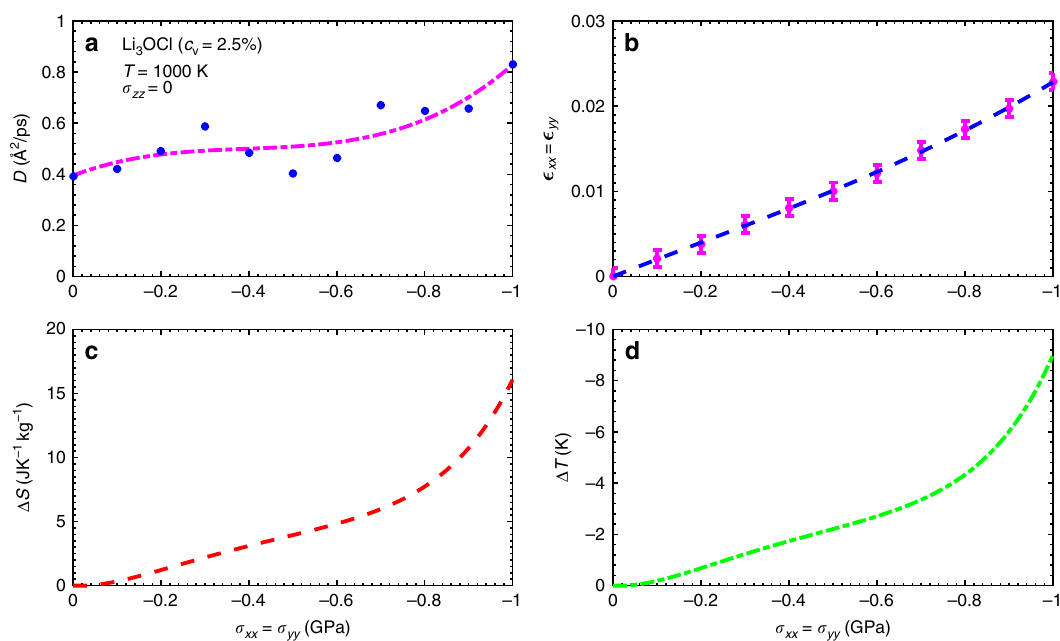
Fig. 3 Mechanocaloric effect in the Li 3 OCl superionic conductor with a point-defect concentration of 2.5%. The Li + diffusion coef fi cient a , in-plane strain b , isothermal entropy shift c , and adiabatic temperature change d estimated at T = 1000 K and expressed as a function of biaxial (tensile) stress. Lines in a , b are guides to the eye, and the error bars in b correspond to the standard deviation from 8,000 con fi gurations generated during the simulations